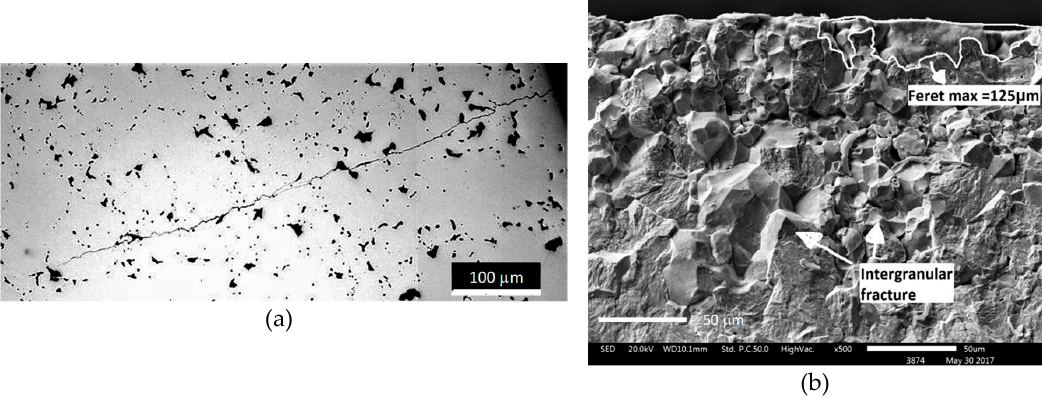
Figure 7. Fractographic inspections of A85Mo05: ( a ) crack path (LOM), ( b ) crack initiation site (SEM).